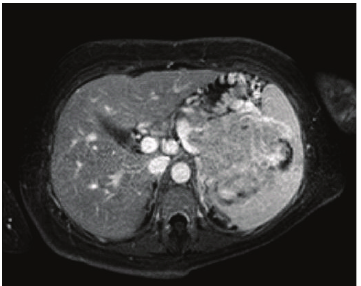
Figure 2: Magnetic resonance imaging of the abdomen was per- formedwhichrevealeda9 × 7 × 8 cmmassinfiltratingthepancreatic tail and spleen along with massive upper abdominal varix formation secondary to splenic vein invasion.